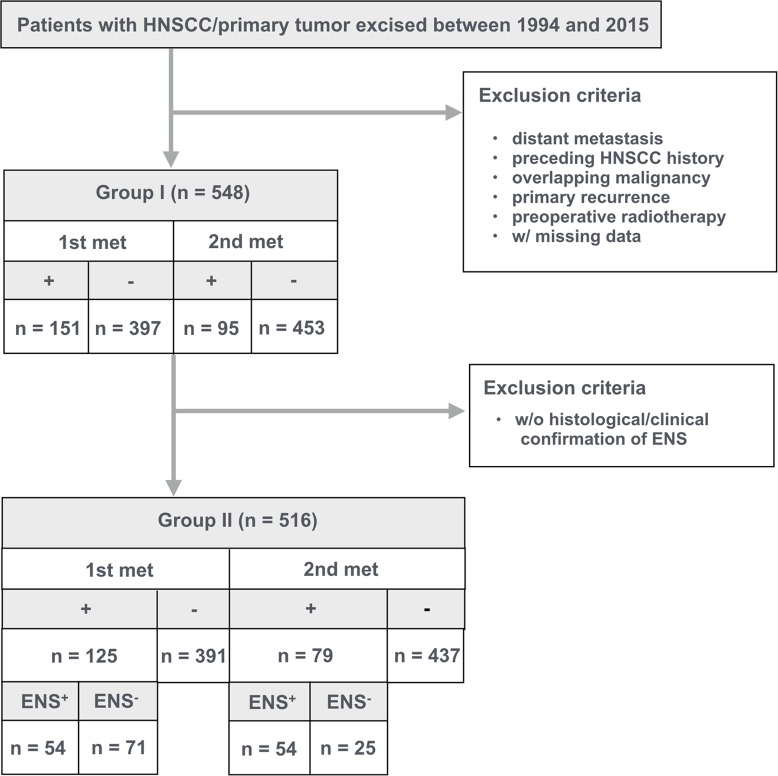
Consort diagram shows definition and metastatic node (met) profiles of 2 patient groups (Group I and II).Group I patients were selected from the clinical data base as those who underwent surgical excision of primary HNSCC between 1994 and 2015, were examined preoperatively and postoperatively with CT or MR imaging for the primary and neck lesions, and did not fit the exclusion criteria listed (78 of 598 had died from cancer at analysis); and Group II patients were from the Group I as those who were histopatholocally or clinically confirmed to have or have not ENS (63 of 516 had died from cancer at analysis).